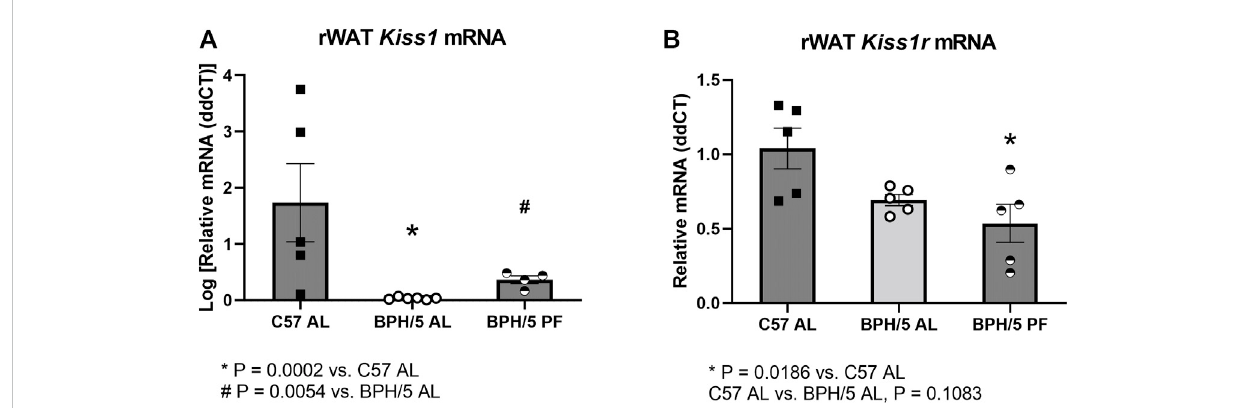
FIGURE 5 ReproductivewhiteadiposetissuekisspeptindownregulationisamelioratedinBPH/5adultfemalesbydietaryweightloss. (A) Kiss1 isdownregulated in ad libitum-fed adult BPH/5 female (BPH/5 AL) rWAT when compared to C57 AL. The downregulation is attenuated in BPH/5 female rWAT by pair feeding(BPH/5PF)tomirrorC57ALfoodintake( n =4 – 6/group,One-wayANOVAandpost-hocTukey ’ stest,mean±SEM,* p =0.0002vs.C57AL,# p = 0.0054 vs. BPH/5 AL). (B) rWAT Kiss1r expression was not different between BPH/5 AL and C57 AL, while rWAT Kiss1r was lower in BPH/5 PF when compared to C57 AL ( n = 5/group, One-way ANOVA and post-hoc Tukey ’ s test, mean ± SEM, * p = 0.0186 vs. C57 AL, p = 0.1083 in BPH/5 AL vs. C57